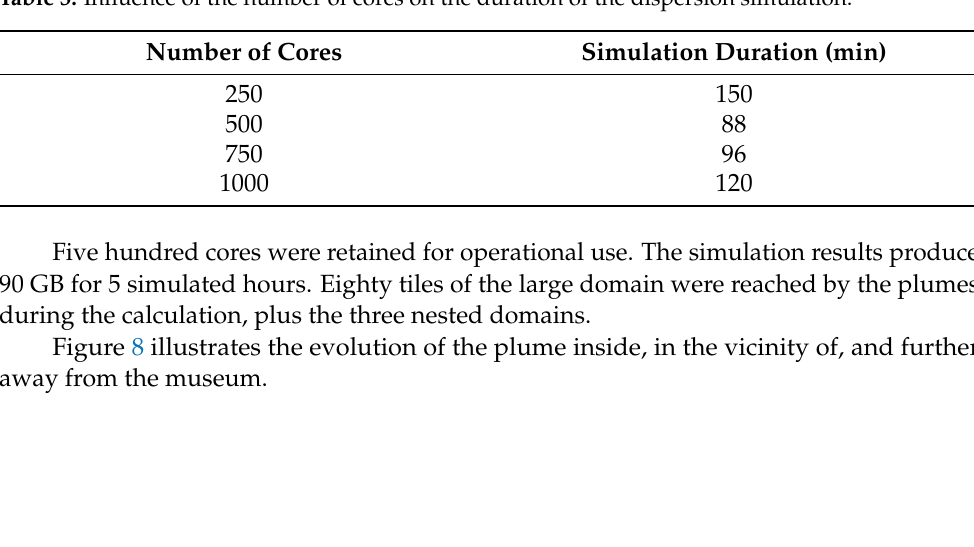
Table 3. Influence of the number of cores on the duration of the dispersion